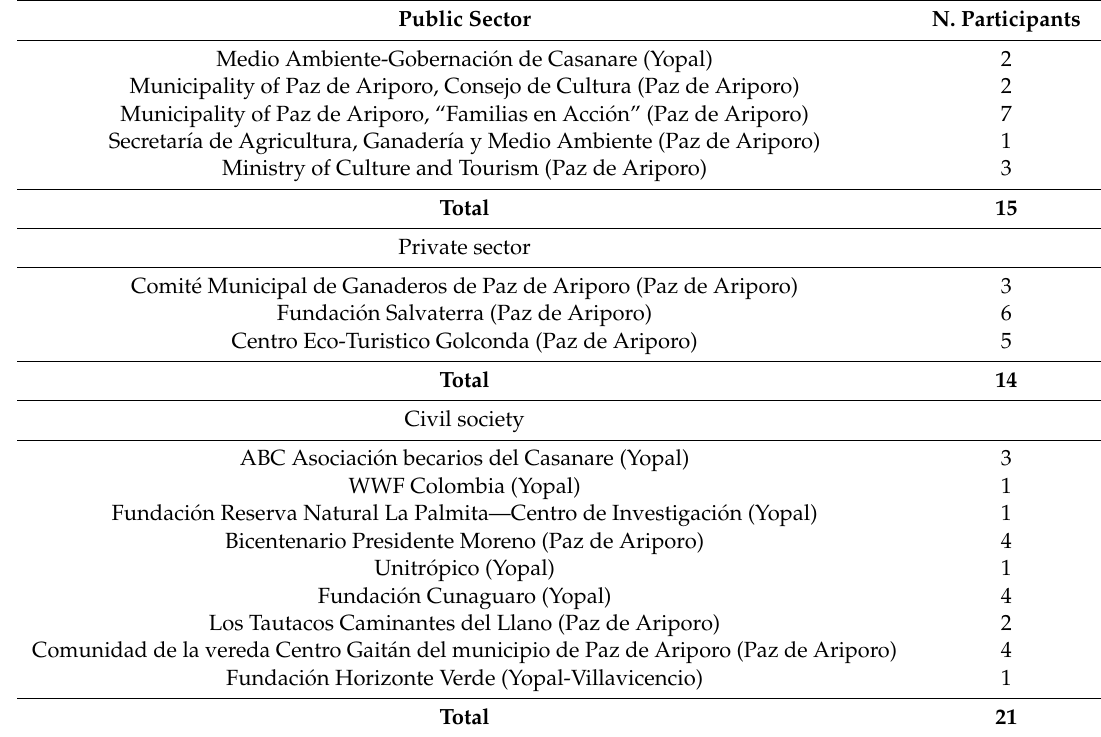
Table A1. Interviews in situ with 17 institutions / groups (50